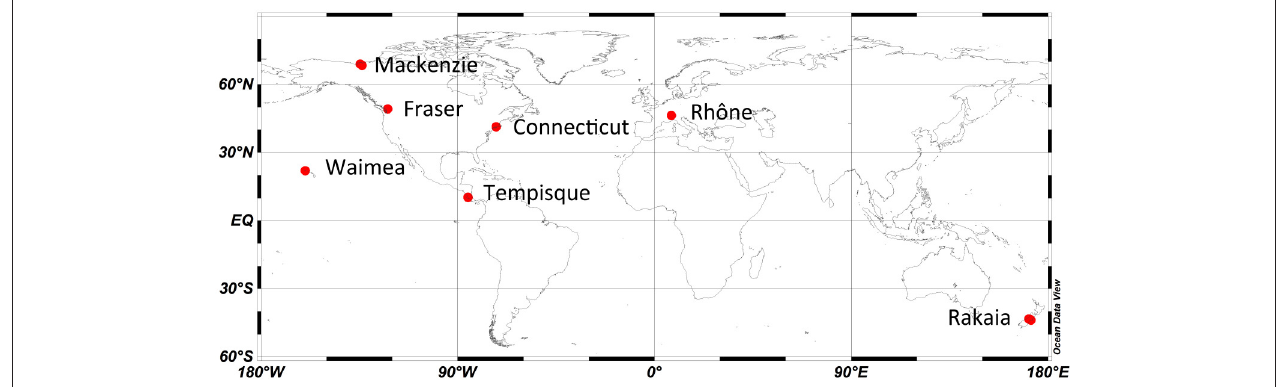
FIGURE 1 | World map indicating the locations of the rivers and soils included in this study.